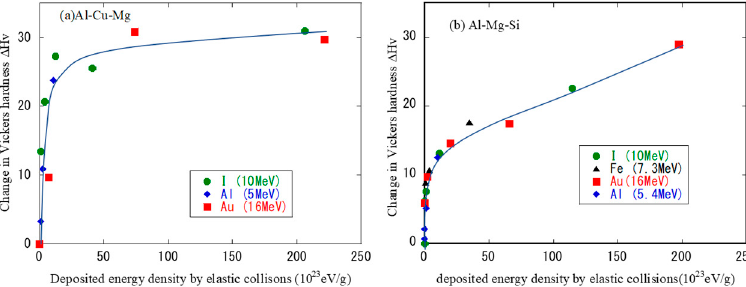
Figure 7. Change in Vickers hardness as a function of deposited energy density by elastic collisions for ( a ) Al-Cu-Mg alloy and ( b ) Al-Mg-Si alloy.